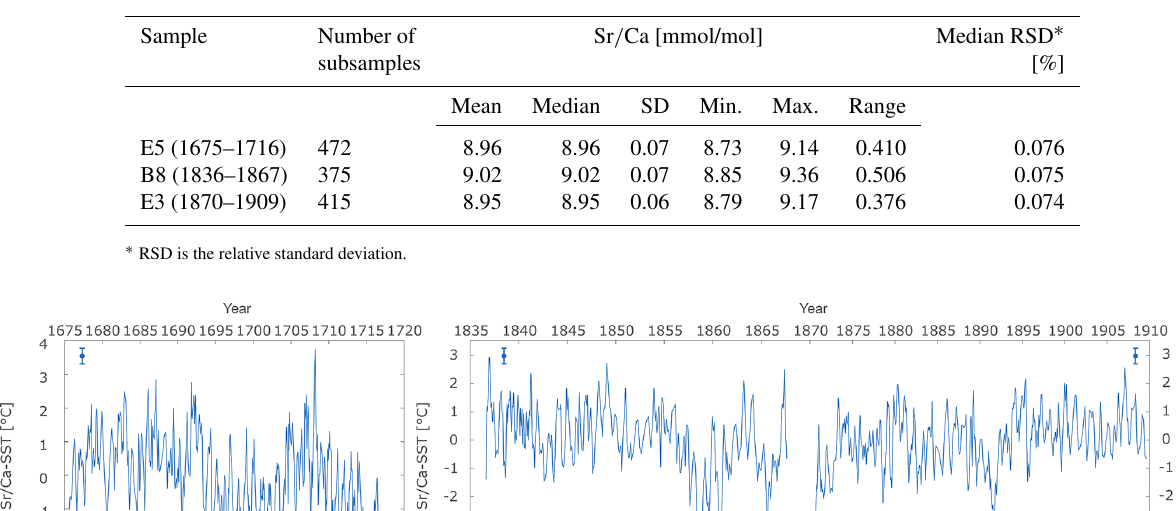
Table 2. Statistical overview of raw Sr / Ca data.